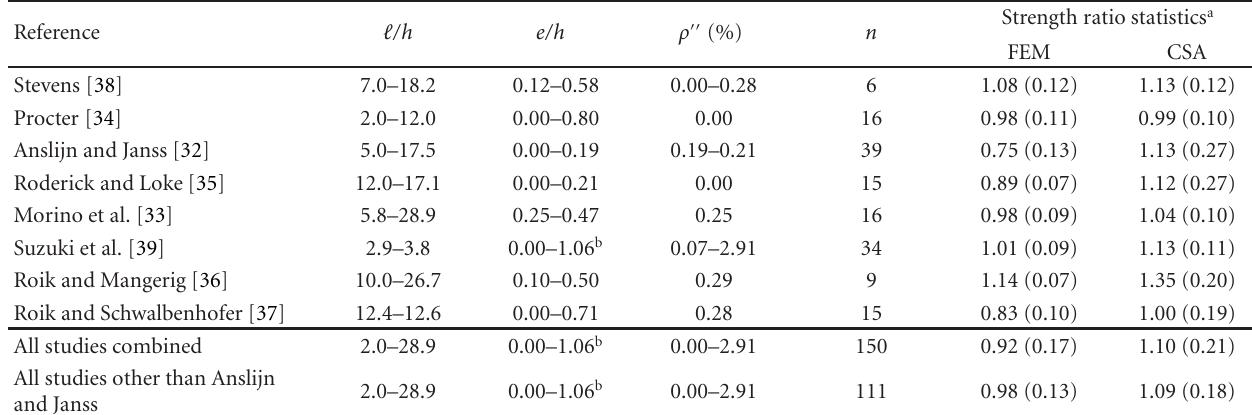
Table 4: Strength ratio statistics for composite columns.